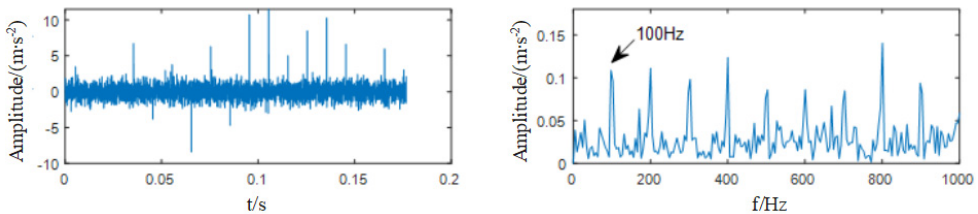
Figure 6. Time-domain and envelope diagrams after SSA-CYCBD enhances the outer ring fault features.